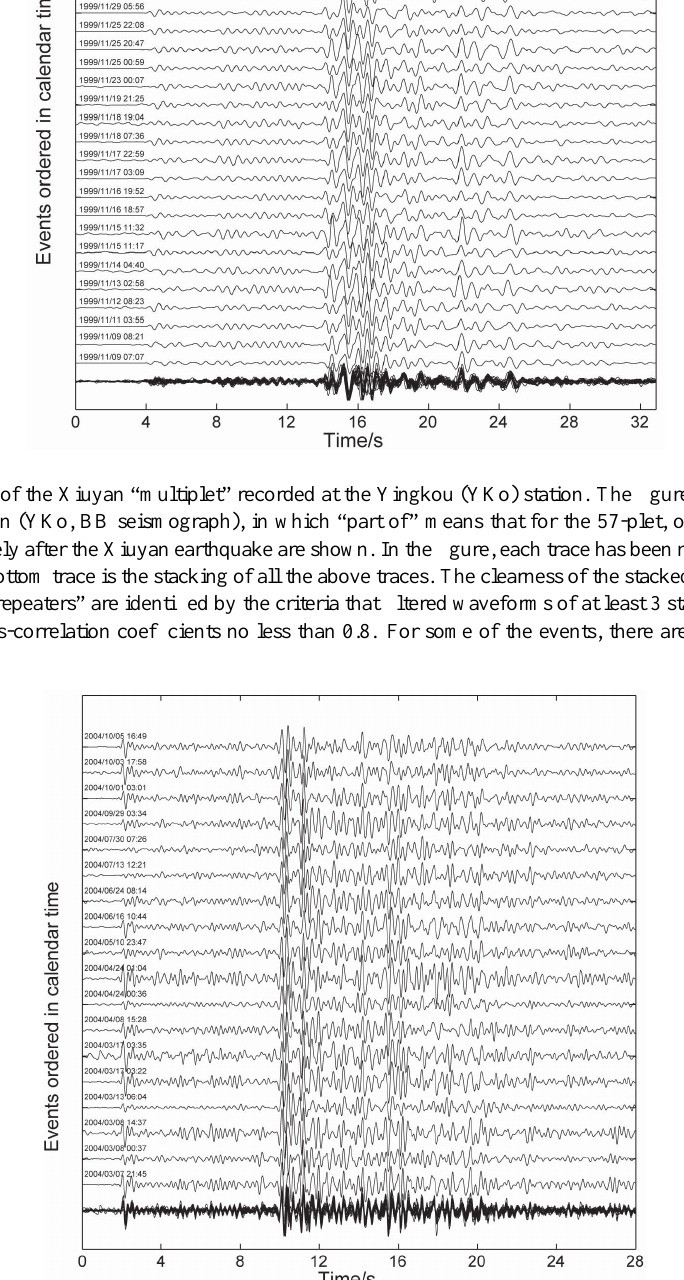
Fig. A2. Filtered seismograms of the Yingkou “multiplet” recorded at the Xiuyan (XYu) station, with the bottom trace being the stacking of all the seismograms. The “repeaters” are identified by the criteria that filtered waveforms of at least 3 stations (not necessarily including the XYu station) have the cross-correlation coefficients no less than 0.8. For some of the events, there are no waveform recordings at the XYu